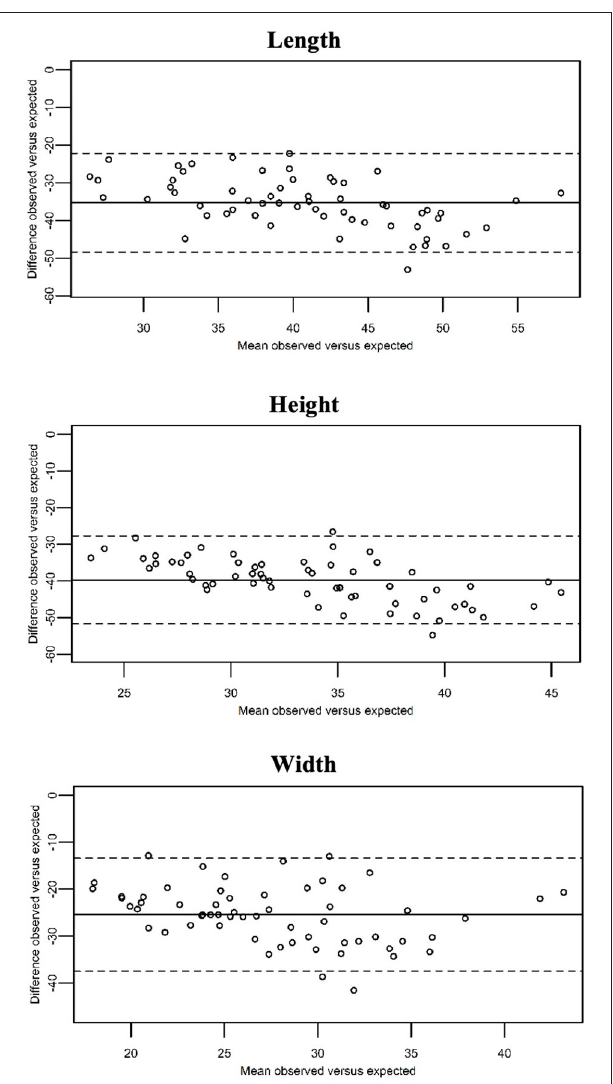
FIGURE 3 | Bland–Altman curves showing the mean of the observed prostatic dimensions in our population of neutered dogs vs. the expected values (x-axis), plotted against the difference between these and the expected prostatic dimension in entire dogs (y-axis). The expected values were calculated by means of the formulas provide by Ruel et al. The continuous line represents the overall mean difference between the observed and the expected prostatic dimensions. As the observed prostatic size increases, the difference between the observed and the expected prostatic dimensions increases as